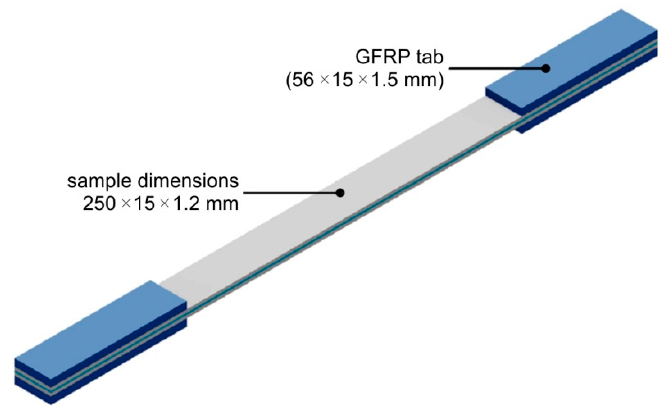
Figure 5. Dimensions of the FML in a variant of a 2 / 1 lay-up used in uniaxial tensile tests (GFRP—Glass Fibre Reinforces Polymer).